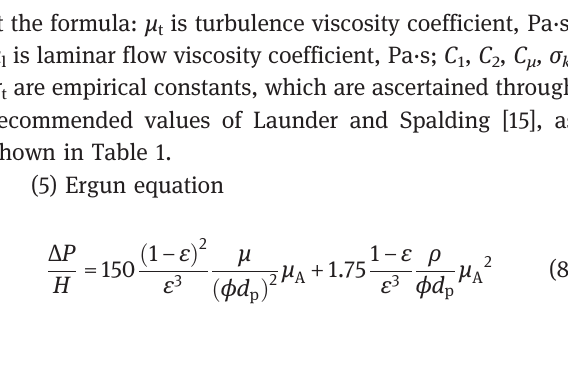
Table 1: Empirical constant of the kinematics dissipate equation. C C C σ σ   μ k k 1-burden surface; 2-ore; 3-coke; 4-softing and cohesive zone; 5-coke window; 6-dead man; 7-tuyere raceway Figure 1: Gas flow distribution model of the blast furnace. 1, burden surface; 2, ore; 3, coke; 4, softing and cohesive zone; 5, coke window; 6, dead man; 7, tuyere